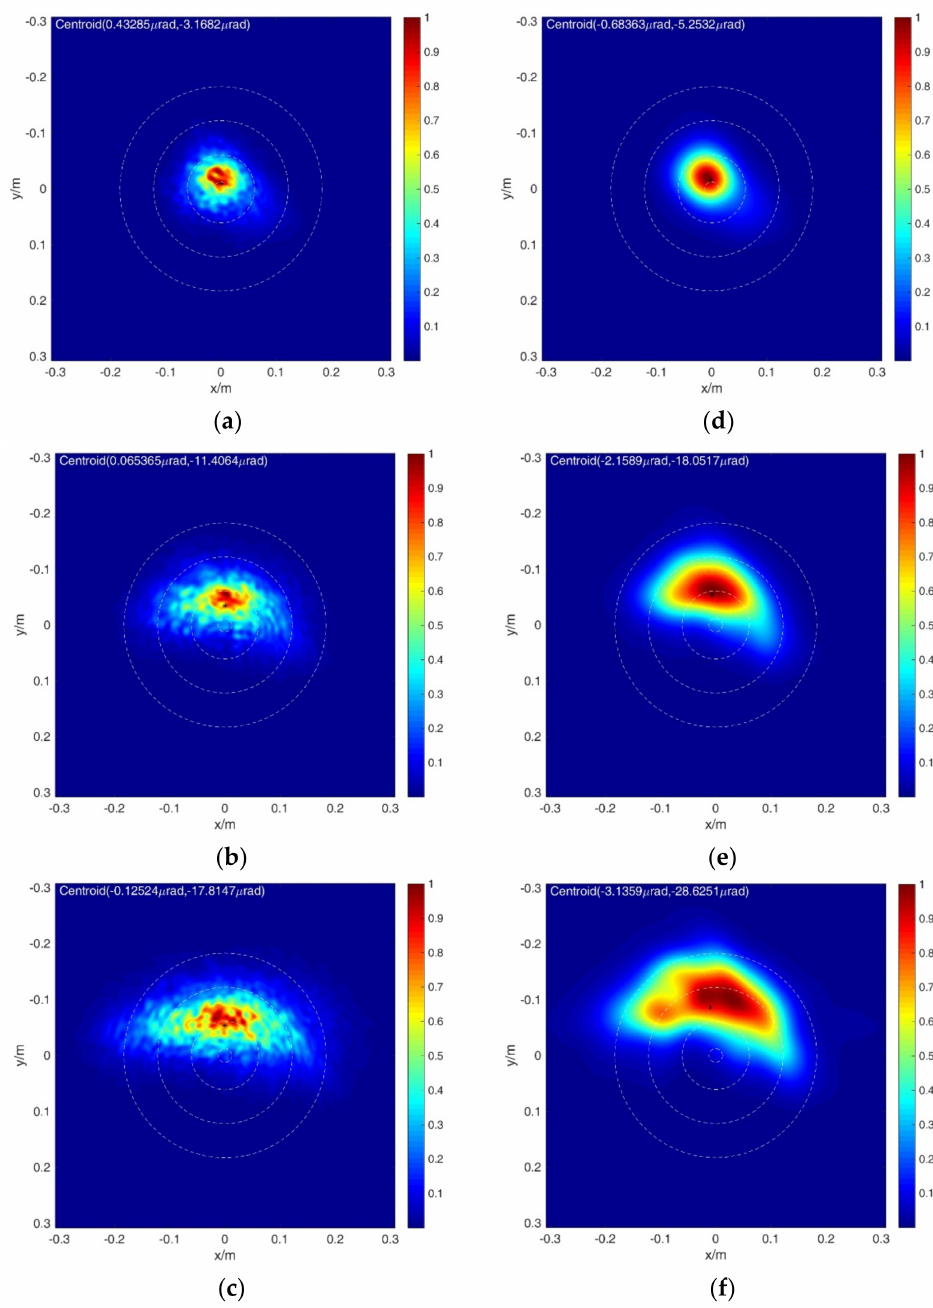
Figure 13. 4D wave optics simulation results ( a – c ) and the far-field intensity distribution for fast calculation results ( d – f ) with S8, S9, and S10 scenario pairs presented top to bottom,